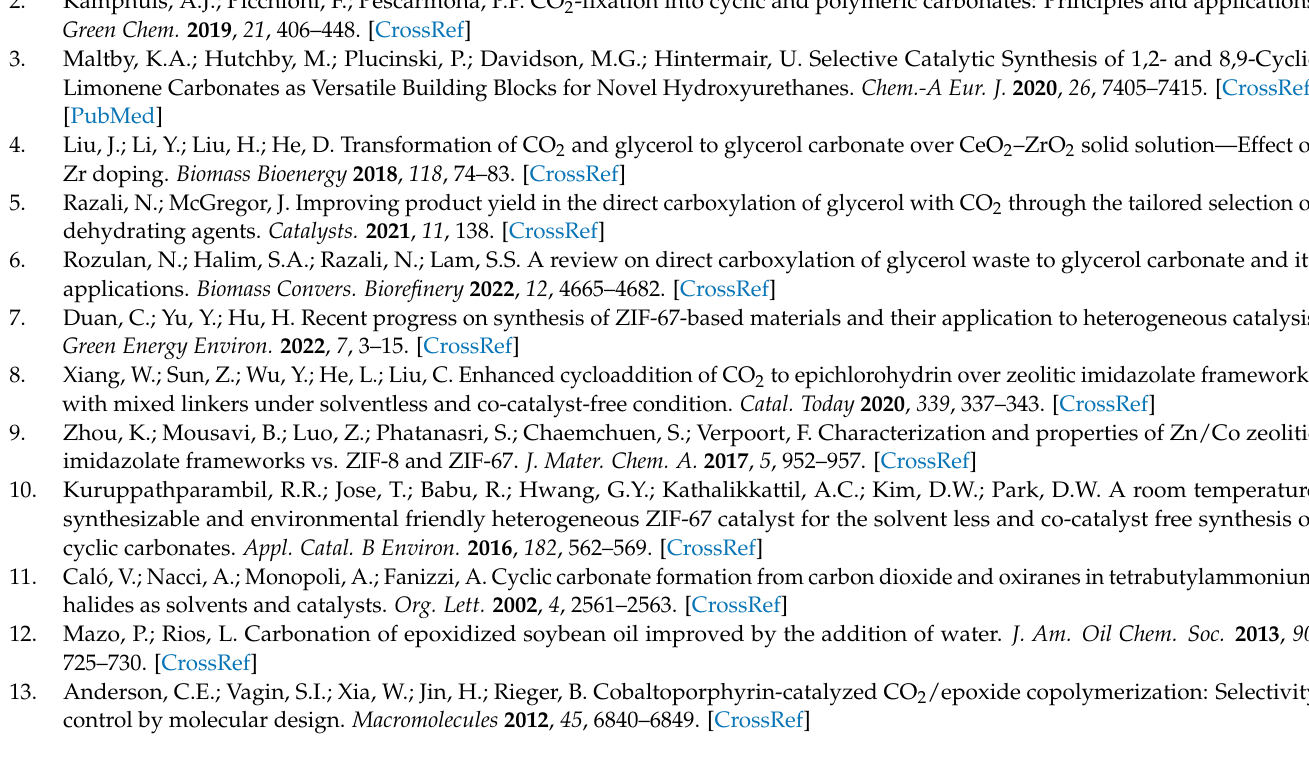
Figure A3. XPS of the four catalysts.